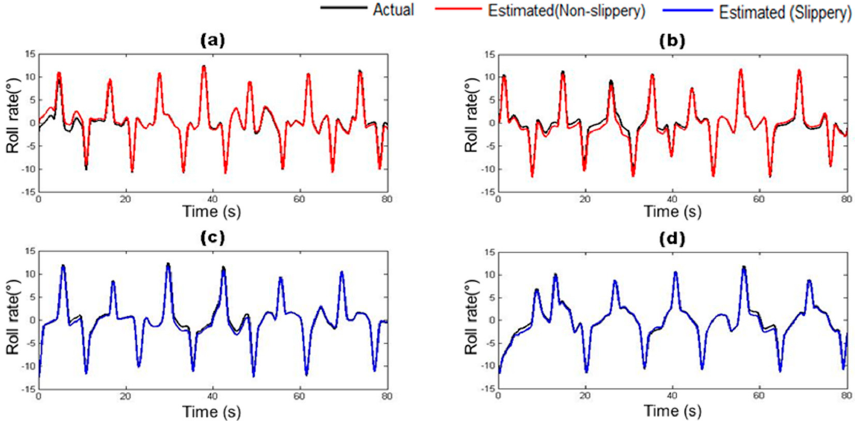
Figure 14. Estimated Suspension Spring Compression depending on road surface condition: ( a ) Dry asphalt; ( b ) Gravel; ( c ) Wet; and ( d ) Snowy.